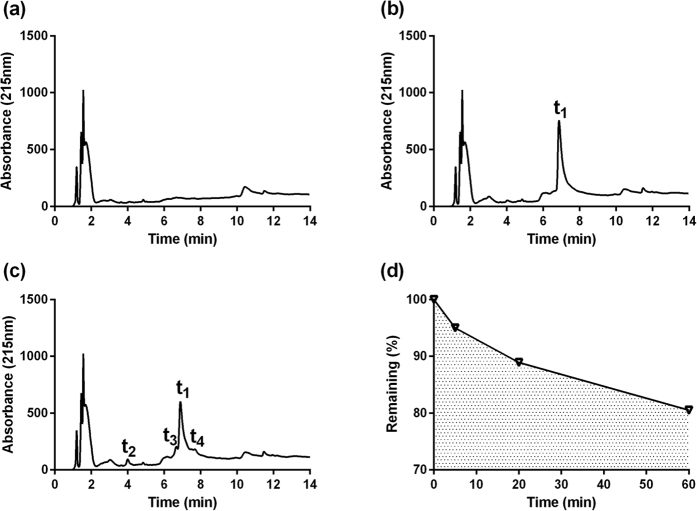
(a) HPLC chromatograms of human saliva; (b) Human saliva spiked with HBAMP (t1 represented the HBAMP, T = 6.9 min); (c) HBAMP (500 μg/ml) incubated in human saliva at 37 °C for 60 min (t2, t3, t4 represented degradation product of HBAMP, Time = 4.0, 6.6 and 7.6 min). (d) Degradation rate of HBAMP in human saliva at 37 °C in 60 min.